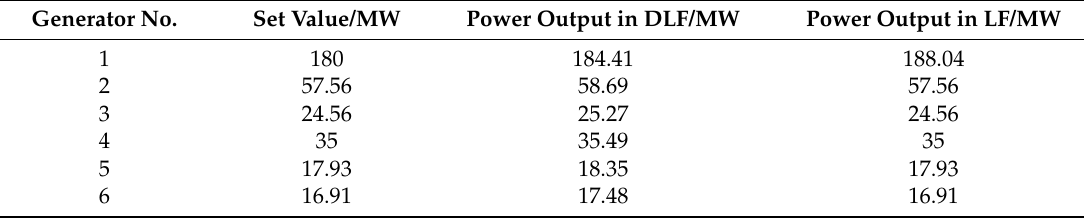
Table 3. The real power output under dynamic load flow (DLF) and load flow